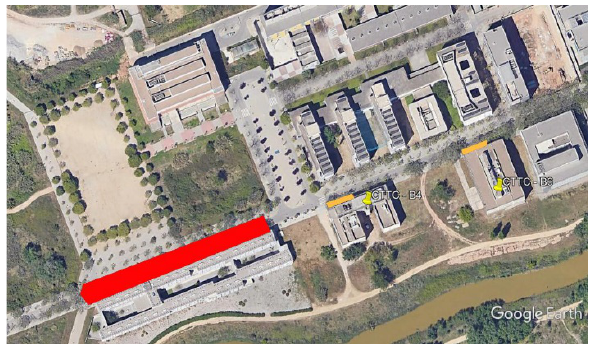
Figure 4 . Parc Mediterrani de la Tecnología where CTTC buildings are located. In red, area with strong multipath conditions. In orange, indoor/outdoor transition areas.